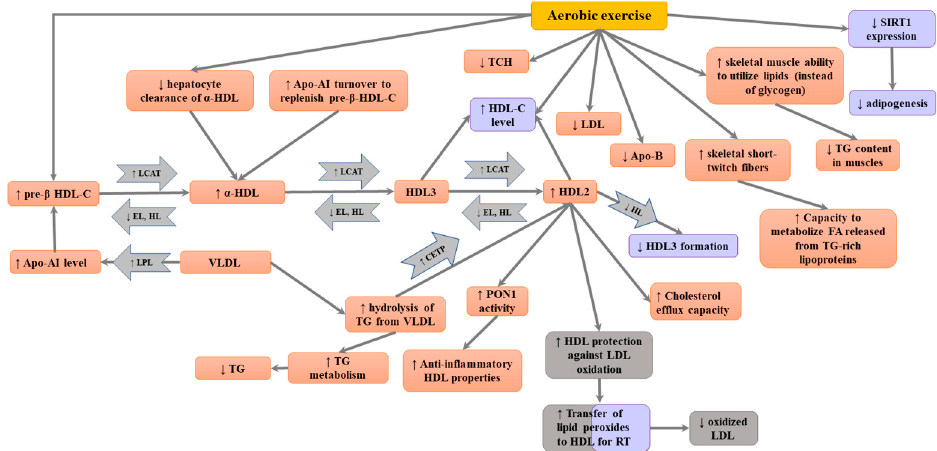
Figure 1. Possible mechanisms of the impact of exercise on HDL level and quality. Grey—effects of acute exercise; violet—effect of chronic exercise; orange—effects of exercise in general. apoA- I, apolipoprotein AI; CETP, cholesteryl ester transfer protein; FA, fatty acid; HDL, high-density lipoprotein; HTGL, hepatic triglyceride lipase; LCAT, lecithin:cholesterol acyltransferase; LDL, low- density lipoprotein; PON1, paraoxonase 1; RT, reverse transport; SIRT-1, sirtuin 1; TC, total cholesterol; TG,